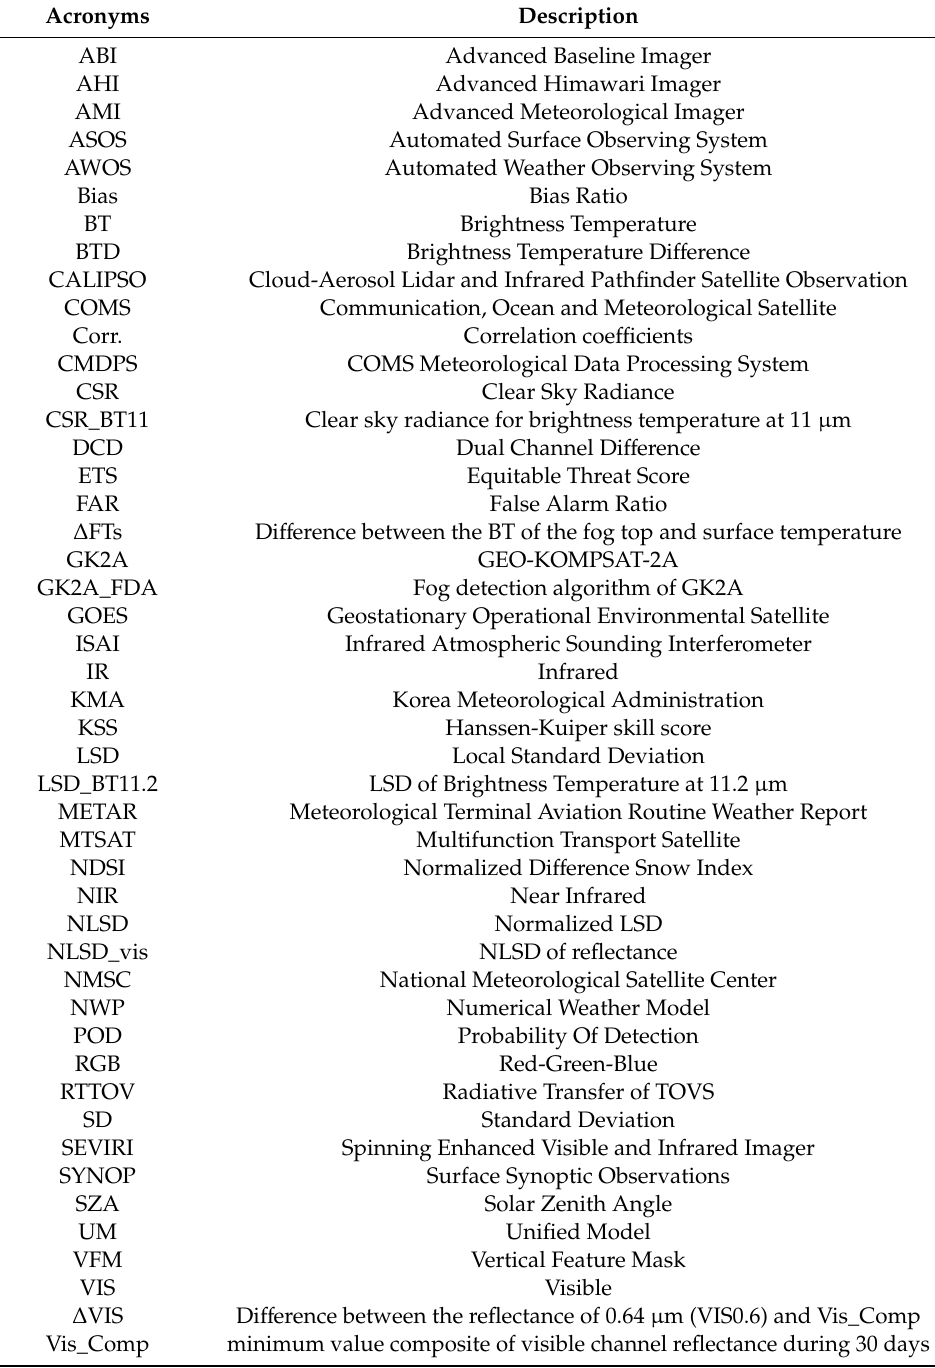
Table A2. List of